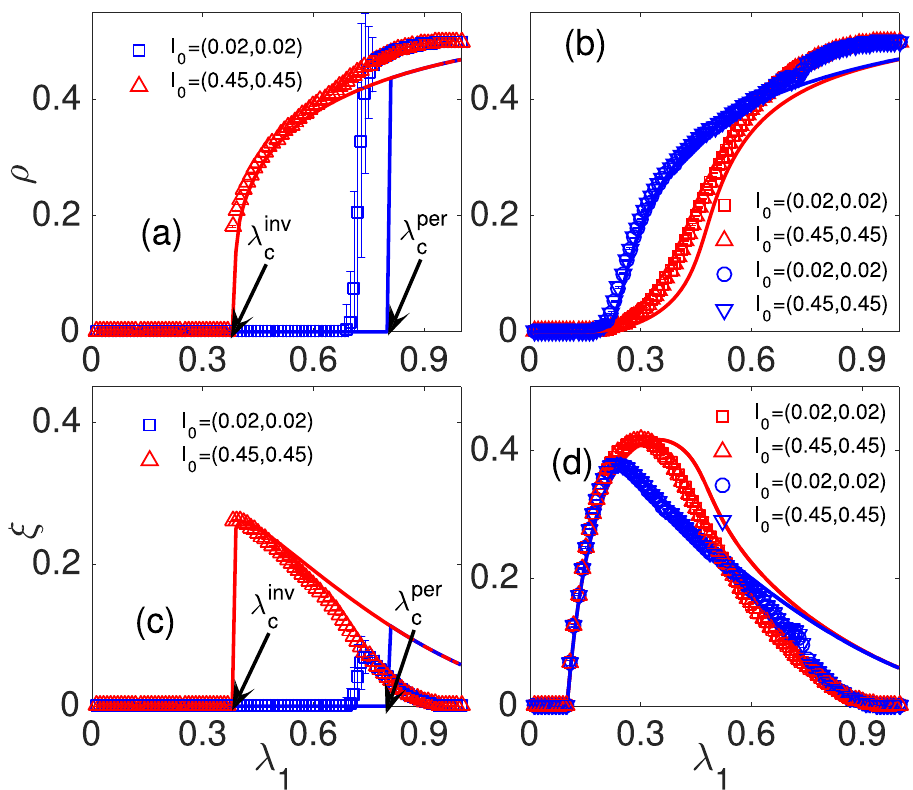
Figure 1. The final fraction of individuals in the adopted and trail state versus the information sharing probability λ on RR network. The final fraction of individuals in the adopted state ρ [( a ) and ( b )] and trial state ξ [( c ) and ( d )] versus λ 1 at Symbols represent simulation results and lines are theoretical